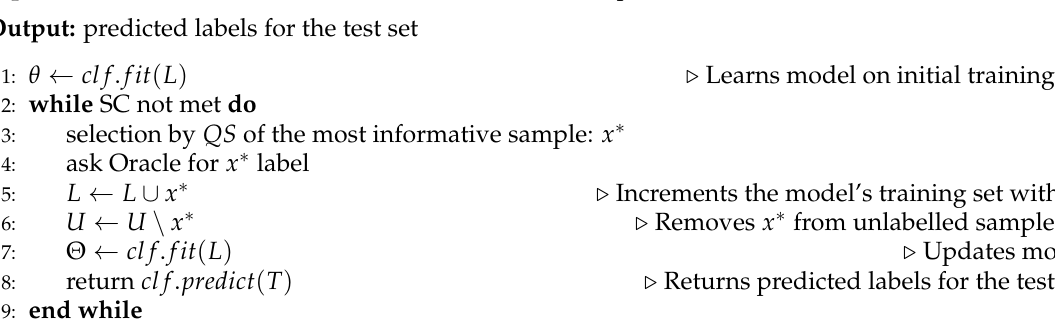
Algorithm 1 General Active